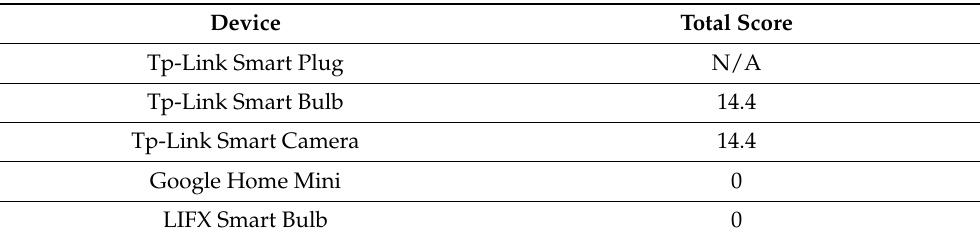
Table 2. Total CVSS scores for each device.